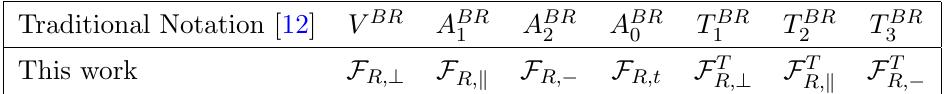
Table 1 . Notation for the various B ! R form factors used in this article (for R a vector resonance), as compared to the \traditional" notation (see e.g. ref. [12]). The notation used in this article has a closer correspondence to the notation for the \parent" B ! P 1 P 2 form